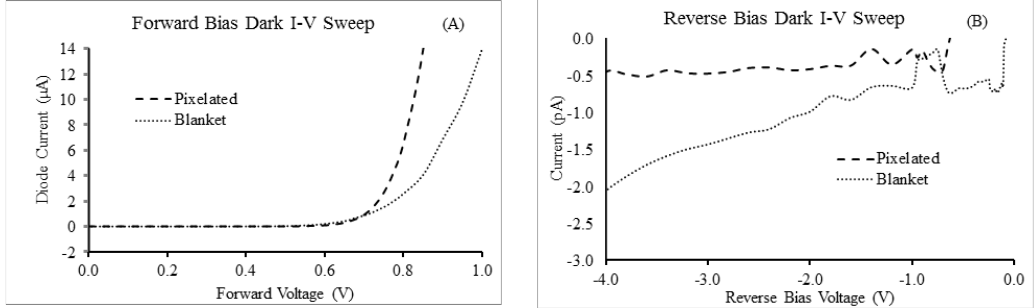
Figure 5. ( A ) Forward and ( B ) Reverse dark I-V sweep comparison between blanket and pixelated PIN diodes.